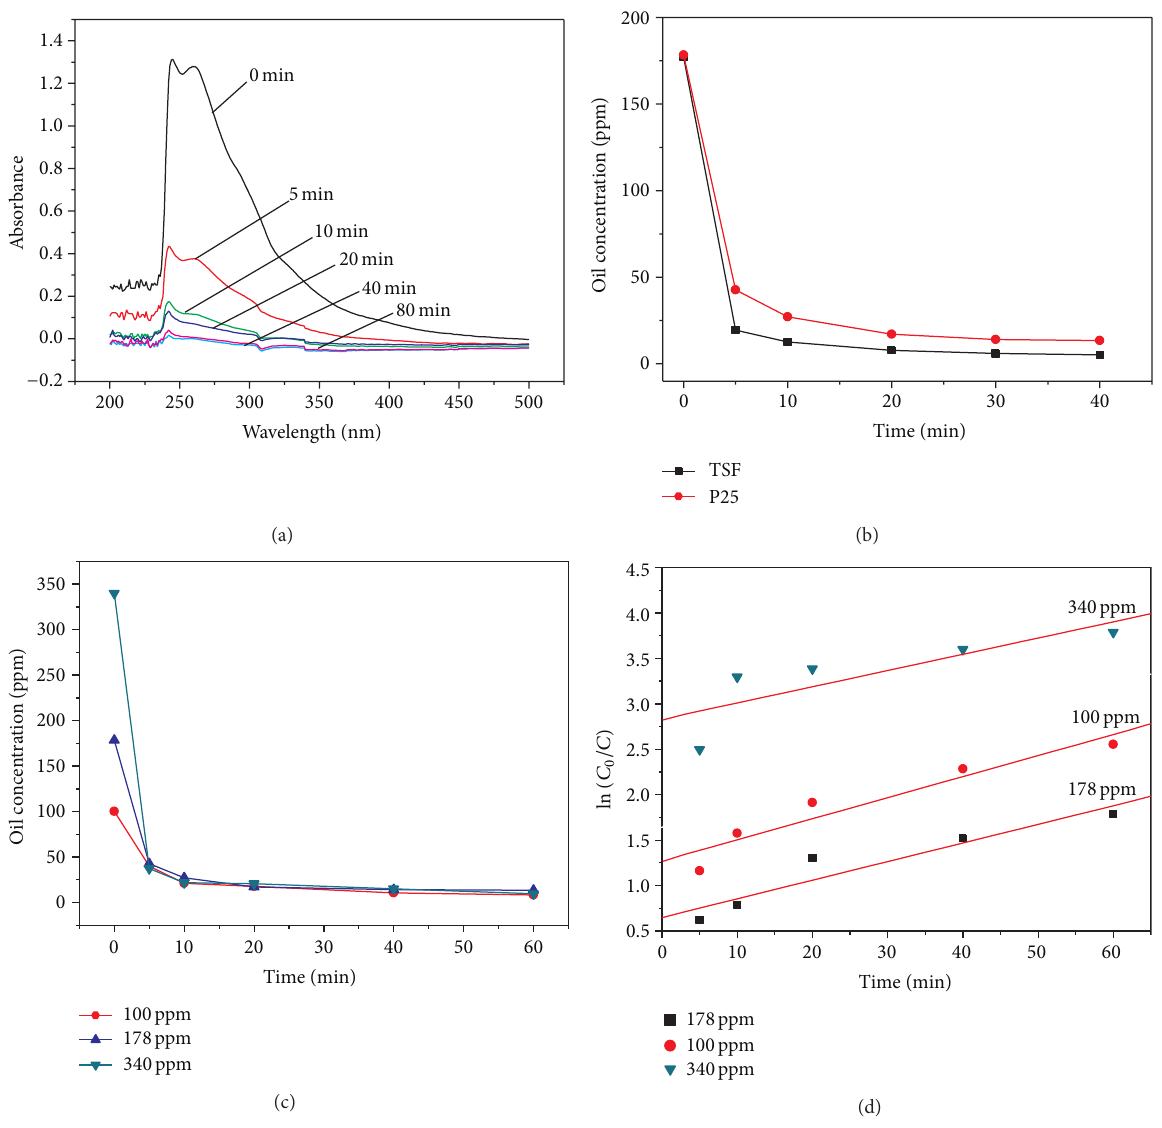
Figure 5: (a) Absorption spectra of oily wastewater exposed to UV light. (b) Photocatalytic performance of TSF and P25. (c) The effect of initial oil concentration on the photocatalysis process of TSF. (d) Pseudo-first-order model fitting of (c) in degrading crude oily wastewater with the oil concentration less than 350